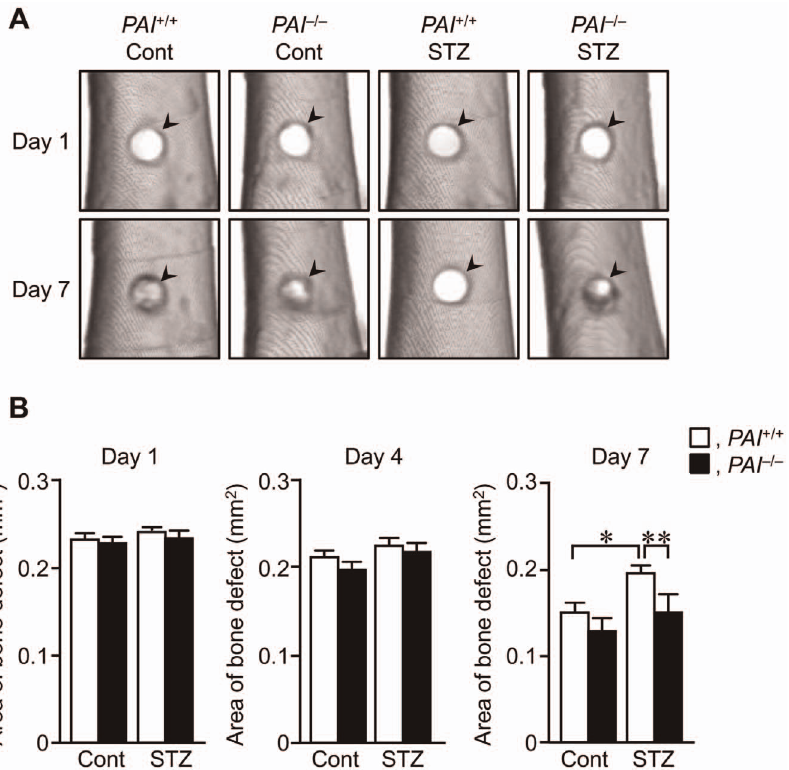
Figure 2. Bone repair after a femoral bone defect. (A) Three-dimensional images of the damaged site on days 1 and 7 after a femoral bone defect in female PAI-1 + / + and PAI-1 2 / 2 mice with or without STZ treatment, as assessed by qCT. The arrowheads indicate the damaged site. (B) Quantification of the area at the damaged site on days 1, 4, and 7 after a femoral bone defect in female PAI-1 + / + and PAI-1 2 / 2 mice with or without STZ treatment. Data represent the mean 6 SEM of 5-6 mice. * p , 0.05, ** p , 0.01. Cont,